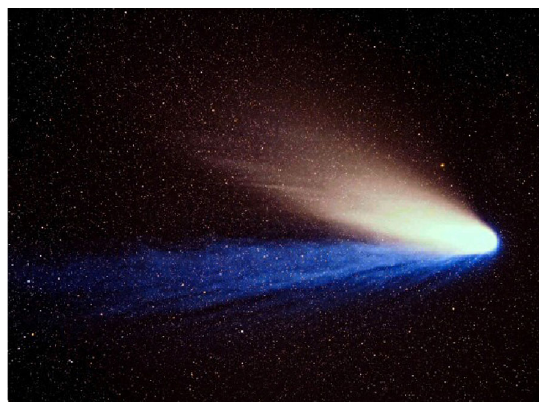
Fig. 1 Comet Hale–Bopp (1997) showing two distinct tails—a broad dust tail (white) and a narrow ion tail (blue). Source : http://www.tivas.org.uk/solsys/